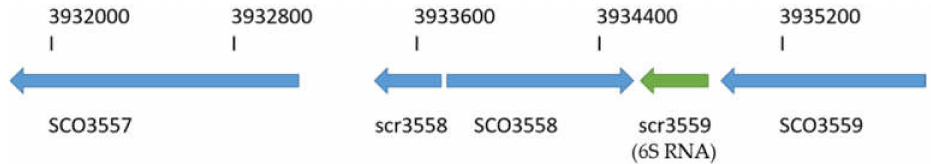
Figure 1. Revised scr3559 gene orientation, relative to its flanking